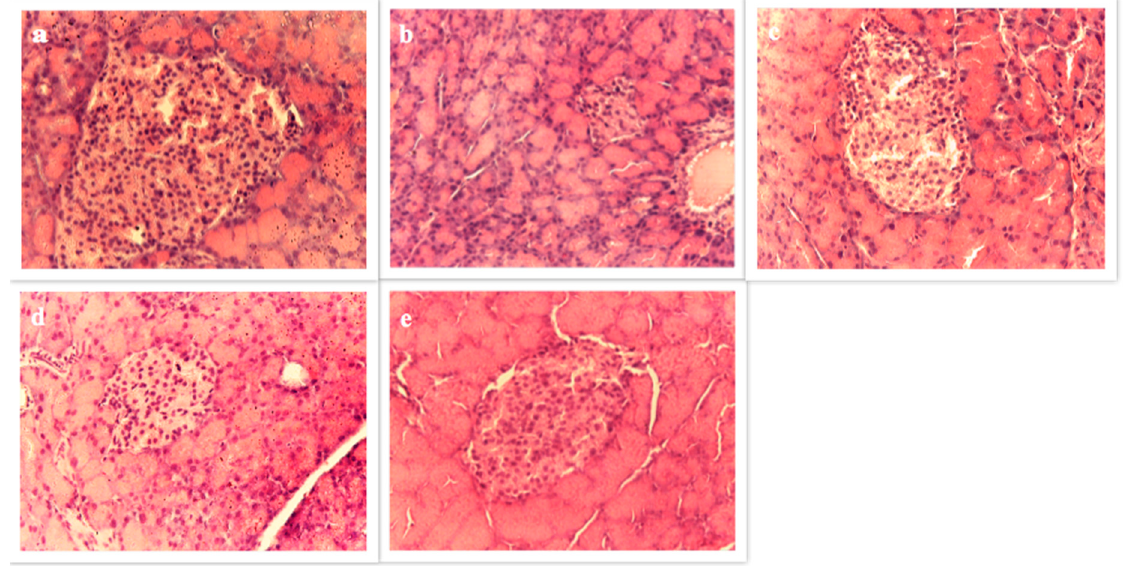
Figure 4. Effect of diabetes and oat treatment on histological alterations in the pancreas. Representative photomicrographs of histological alterations stained with hematoxylin and eosin at ×400 magnification. Normal control ( a ); Diabetic control ( b ); Metformin ( c ); Amlal ( d ); F11-5 ( e ).